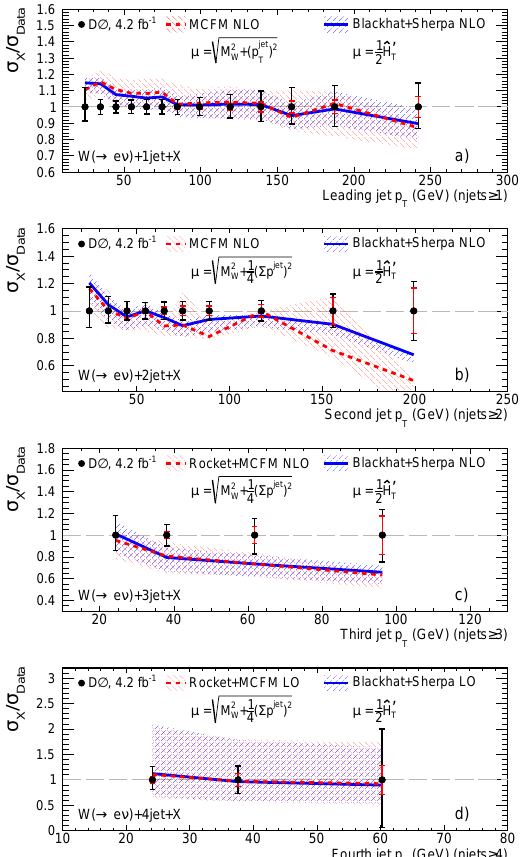
Fig. 4. The ratio of pQCD predictions to the measured di ff erential cross sections for the n th jet p T ( n = 1 4). The corrected data − and theory predictions are normalised by the measured inclusive W boson cross section and the predicted inclusive W boson cross sections, respectively. The inner (red) bars represent the statis- tical uncertainties of the measurement, while the outer (black) bars represent the statistical and systematic uncertainties added in quadrature. The shaded areas indicate theoretical uncertainties due to variations of the factorisation / renormalisation